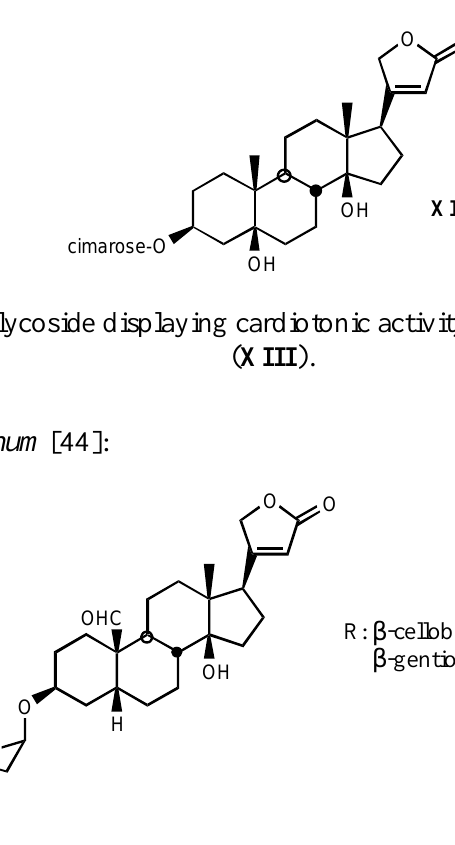
Figure 9. Cardiotonic digitalis-like glycosides isolated from Apocynum cannabinum ( XIV and XV